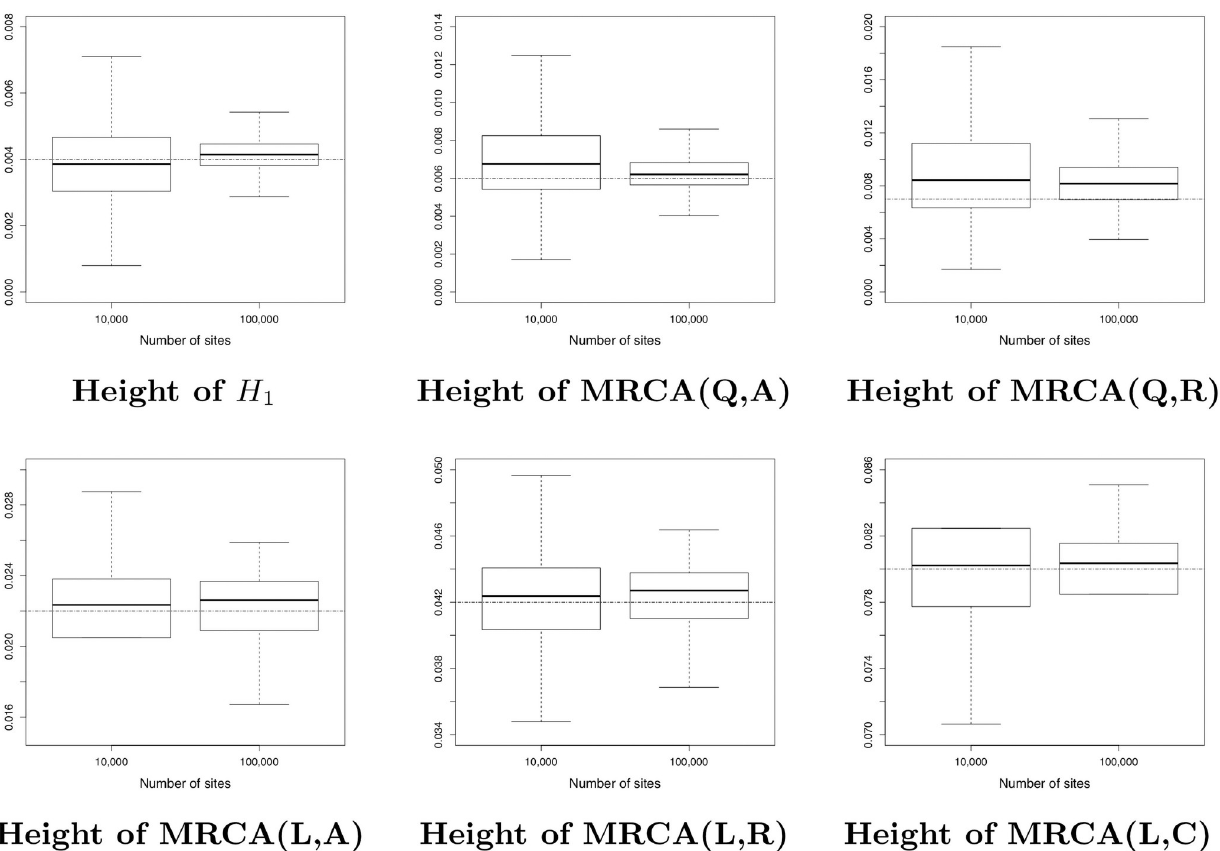
Fig 12. Estimated node heights of network A (see Fig 7), as a function of the number of sites. Heights are measured in units of expected number of mutations per site. True values are given by the dashed horizontal lines. Same framework as in Fig 10. The initials MRCA stand for “Most Recent Common